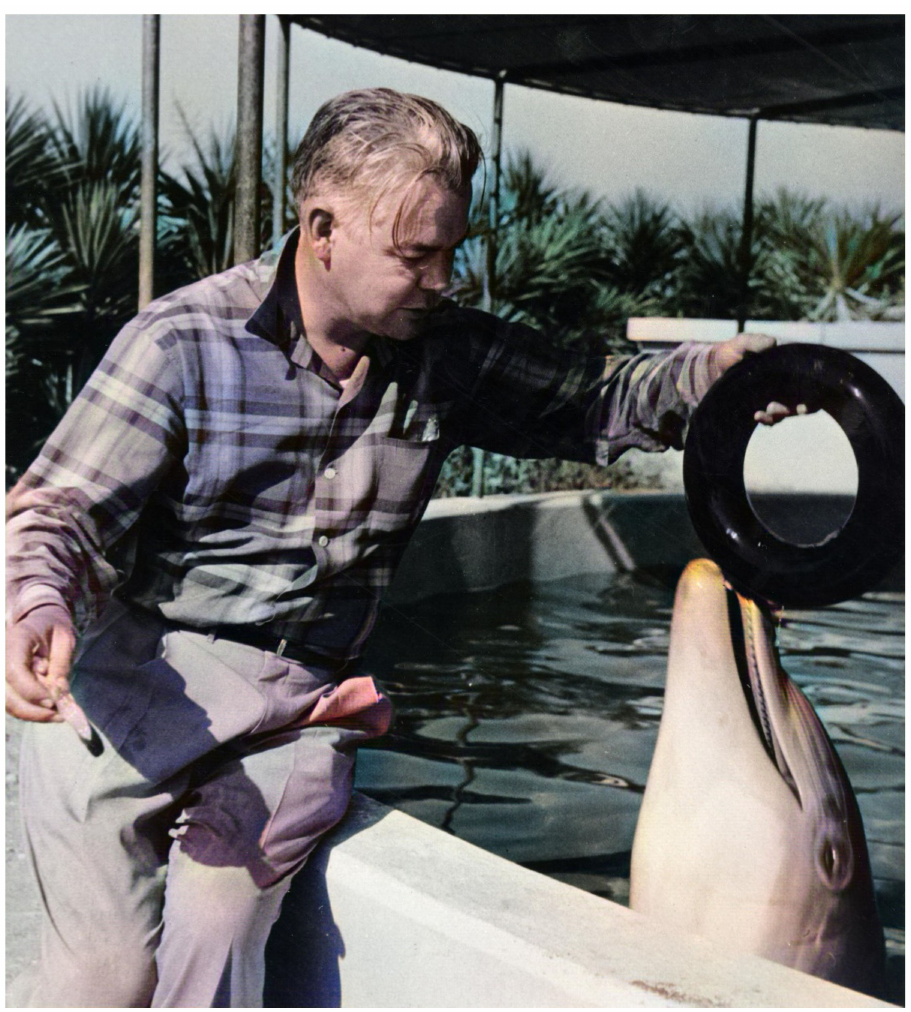
Figure 3. Colorized photo of Keller Breland training a dolphin at Marine Studios/Marineland of Florida, circa 1957. (Reproduced from [40] with permission of John Wiley and Sons,